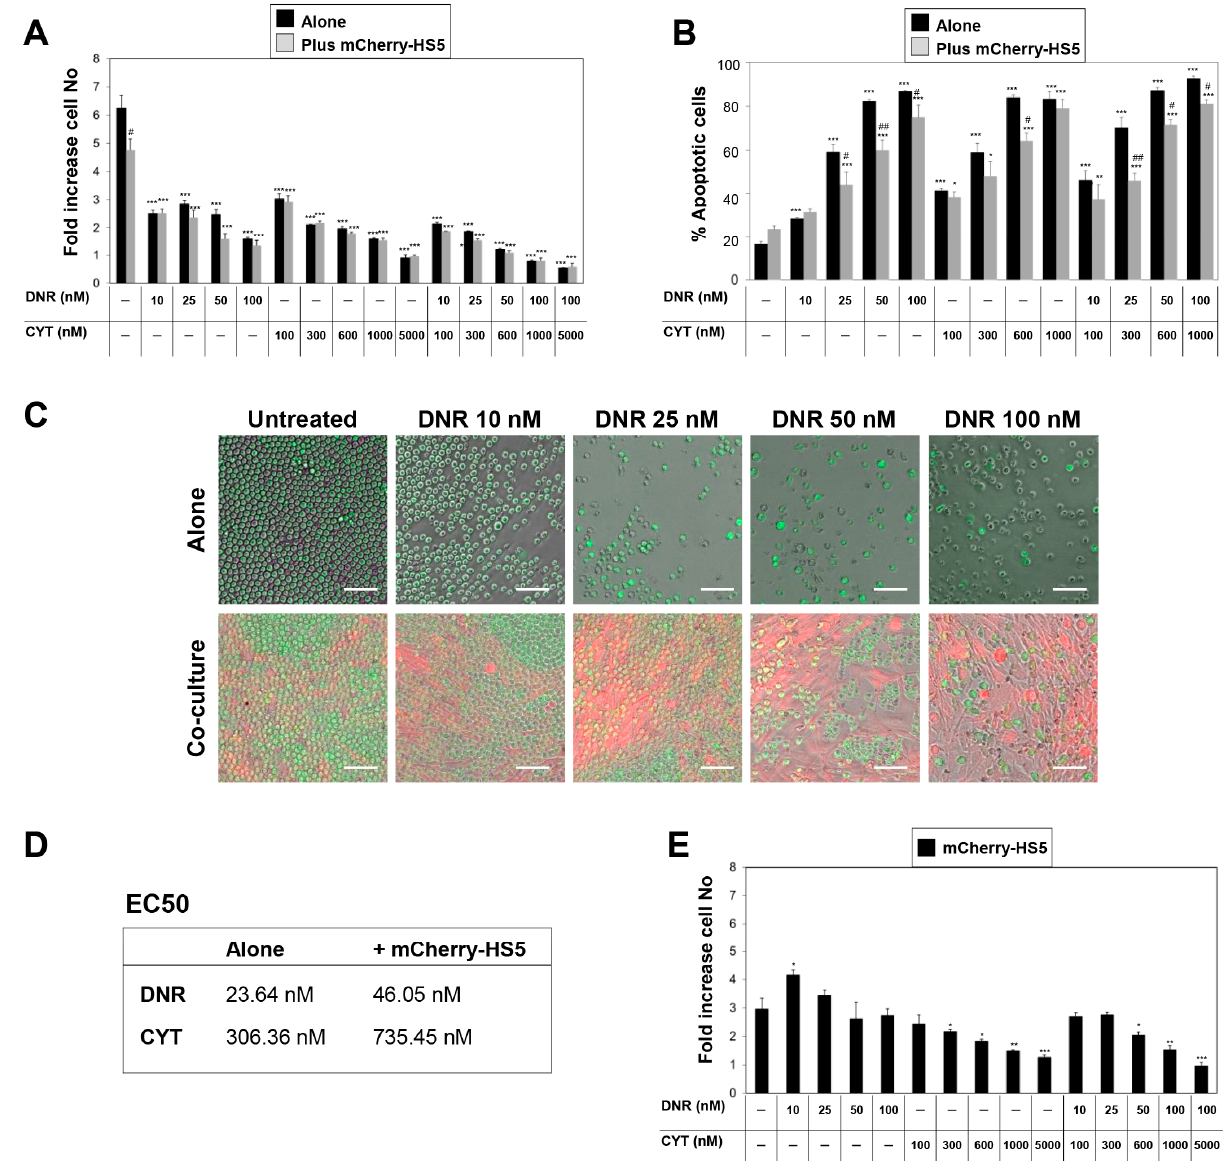
Figure 3. Analysis of the response to daunorubicin and cytarabine of eGFP–MOLM-14 cells cultured alone or in heterotypic cultures with mCherry-HS5 cells. Analysis of changes in proliferation ( A ) and percentage of apoptotic cells ( B ) in cultures of eGFP-MOLM-14 cells at Day 3 post-seeeding. Cultures were left or were treated with daunorubicin (DNR) or cytarabine (CYT) as single agents or in combination; ( C ) Composites of phase contrast and fluorescence micrographs of GFP-MOLM-14 cells (green) cultured alone or in co-culture with mCherry-HS5 cells (red) generated using NIS-Elements AR 5.10 software. Bar 40 μ M; ( D ) Table showing the half maximal efficacious concentration (EC50) values of DNR and CYT for inducing apoptosis of eGFP-MOLM-14; ( E ) Proliferation of mCherry-HS5 cells. * p < 0.05; ** p < 0.01; *** p < 0.005 ANOVA test versus untreated cells under the same culture conditions. # p < 0.05; ## p < 0.01 post-hoc Student T-test comparing cells co-cultured with mCherry-HS5 cells vs. cells cultured alone treated with the same concentration of the drug under study.